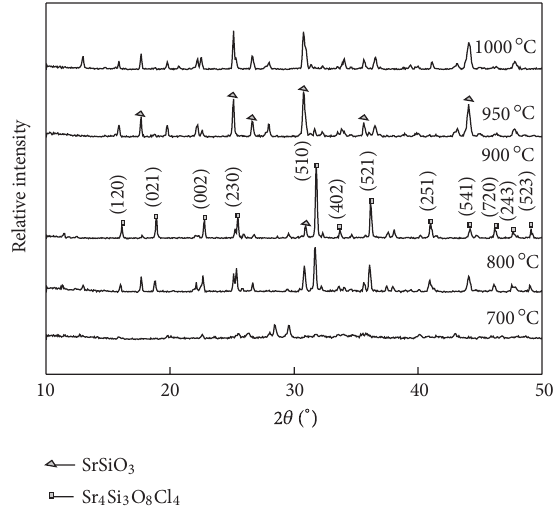
F 1: XRD patterns of the samples obtained at different reduc- tive